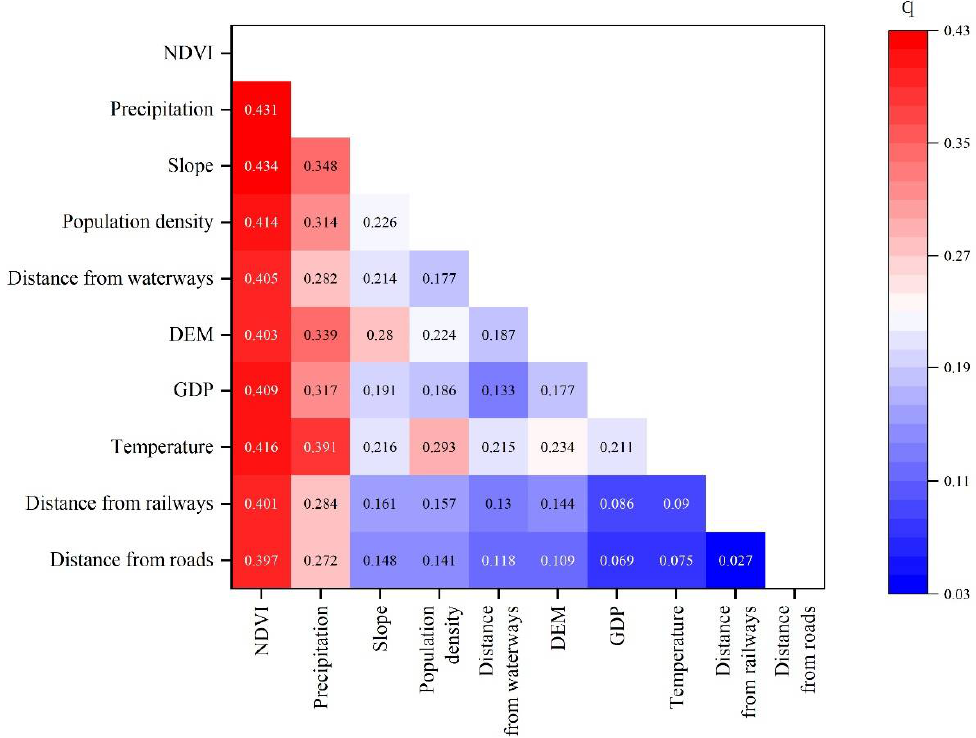
Figure 10. The q value of the interaction effects for two different influencing factors on the distribution of grassland ESV inInner Mongolia.